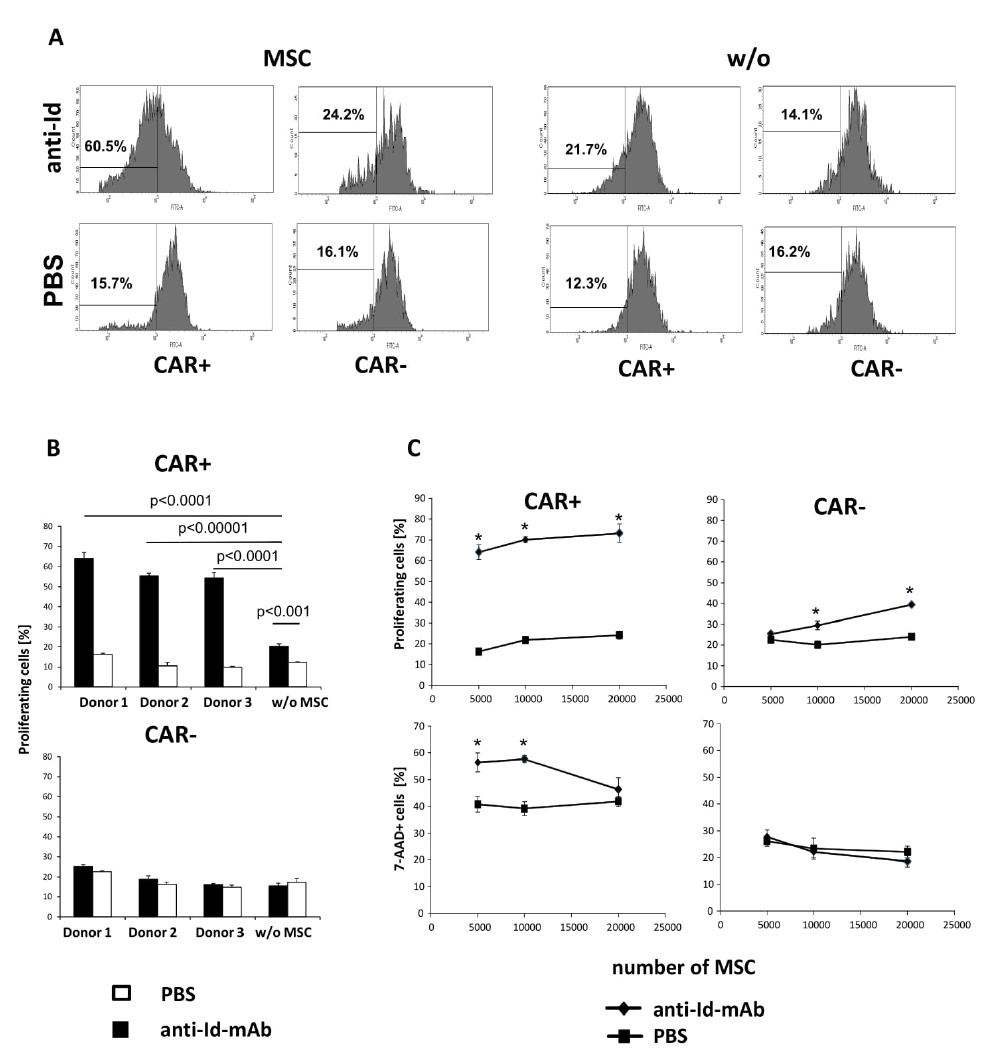
Figure 4. MSCs modulate antigen driven CAR T cell amplification. Anti-CEA CAR T cells were CFSE labeled and co-cultivated (2.5 × 10 4 cells / well) together with MSCs in 96-well plates that were coated with the CAR specific anti-idiotypic mAb BW2064 (4 µ g / mL) or PBS for control. After 5 days cells were recovered, CAR T cells stained with an anti-IgG-PE antibody to detect the CAR and analyzed by flow cytometry. Dead cells were identified by 7-AAD staining (1 µ g / mL) and the number of proliferating cells was determined by CFSE dilution. ( A , B ) CAR T cell proliferation in presence of MSCs (each 5000 cells / well) of three di ff erent donors. ( A ) Histograms of a typical experiment. ( B ) Summary of CAR T cell proliferation in presence of MSC. ( C ) CAR T cell proliferation and cell death in presence of increasing numbers of MSCs (5000–20,000 cells / well). Values represent the mean of replicates +/ − standard deviation (SD). Significant di ff erences were calculated by Student’s T test; * p <